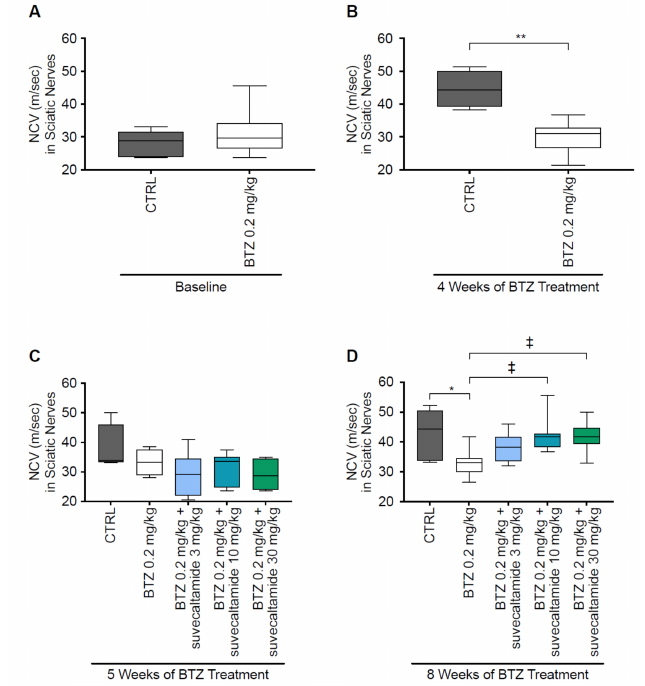
Figure 2. Sciatic nerve conduction velocity (NCV). Conduction velocity obtained from sciatic nerves by electromyography during phase 1 (( A ) baseline and ( B ) 4 weeks) and phase 2 (( C ) 5 and ( D ) 8 weeks) in a rat model of BTZ-induced CIPN. BTZ—bortezomib; CIPN—chemotherapy-induced peripheral neurotoxicity; CTRL—untreated animals. * p < 0.05 vs. CTRL; ** p < 0.01 vs. CTRL;